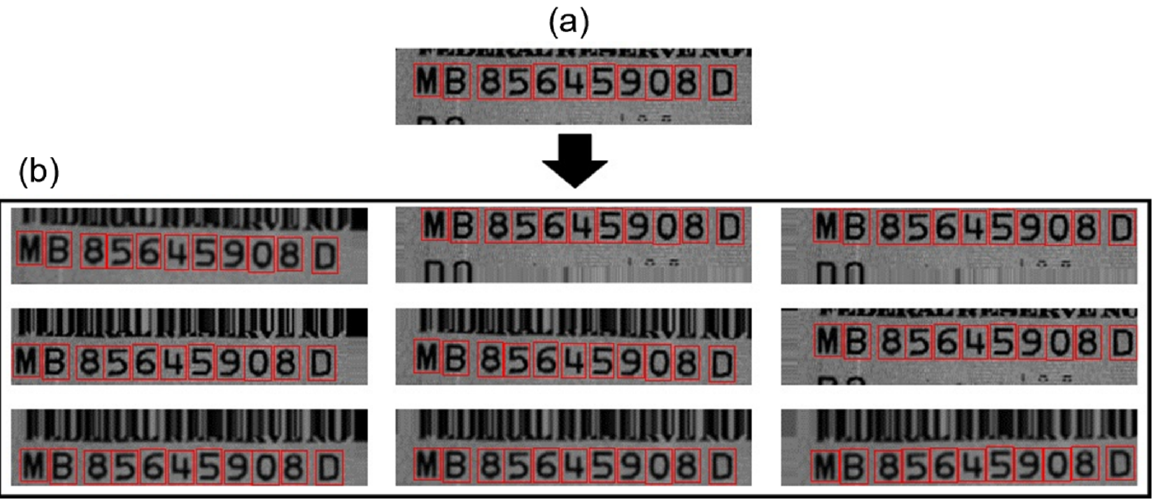
Figure 6. Example of image data augmentation for banknote image data. Red boxes indicate the ground truth. ( a ) Original image; ( b ) images obtained from data augmentation.